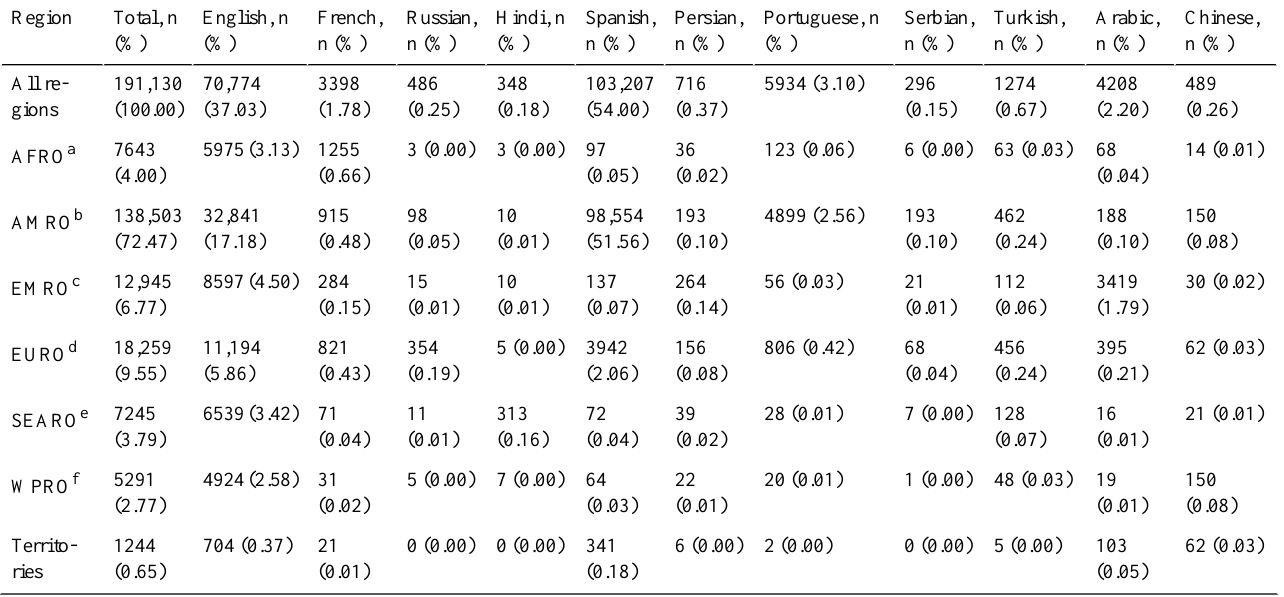
Table 1. Introductory course use overview by World Health Organization region and language used for course enrollments (N=191,130).